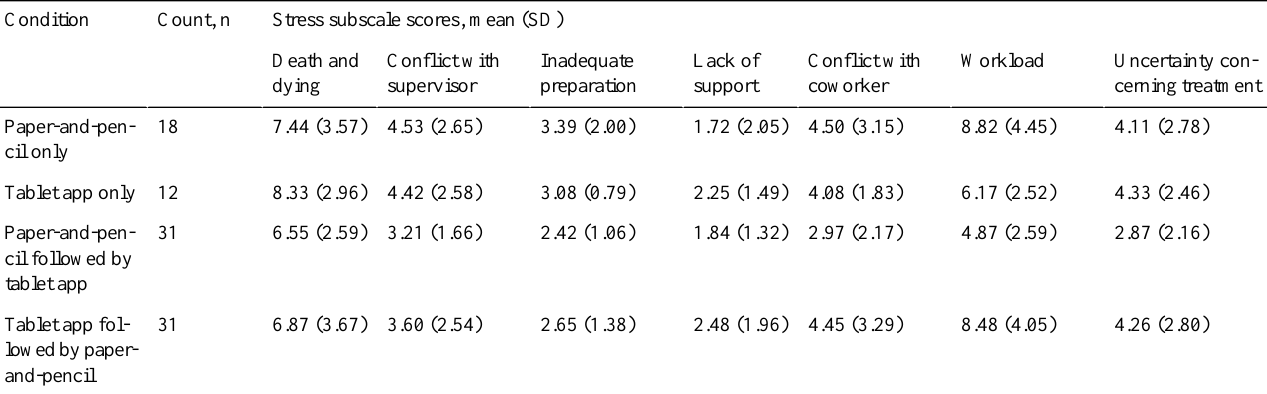
Table 3. Stress subscale scores for each condition.